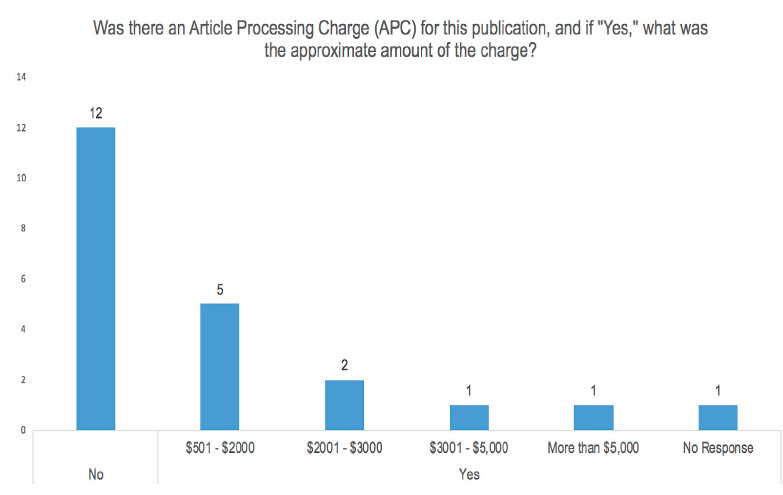
Figure 1. Prevalence and Amount of APC.